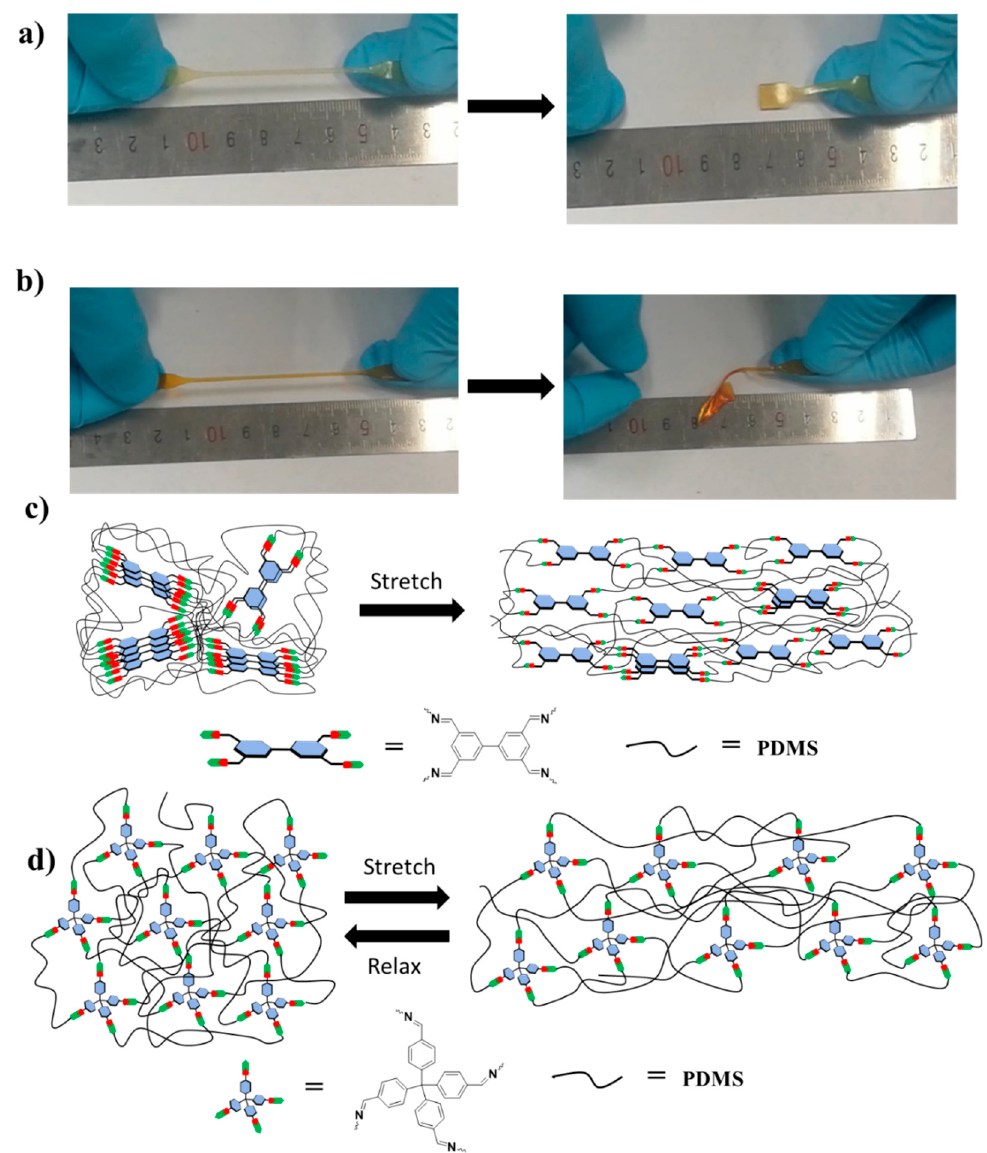
Figure 5. ( a ) Photographs illustrating the stretching and recovery of BTA-PDMS-25000. ( b ) Photographs illustrating the stretching and deformation of TFPM-PDMS-25000. ( c ) The possible mechanism of the stretching and recovery of BTA-PDMS-25000. ( d ) The possible mechanism of the stretching and recovery of